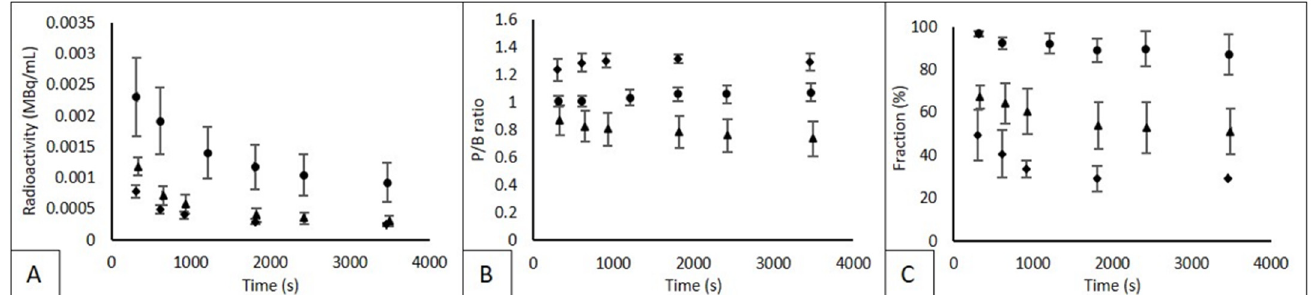
Figure 1. Typical examples of whole ‐ body scans per tracer. Abbreviations: ( A ): 11C ‐ erlotinib ( B ): 18F ‐ afatinib ( C ): 11C ‐ osimertinib. Tumors are circled in red. Table 1. Baseline characteristics.